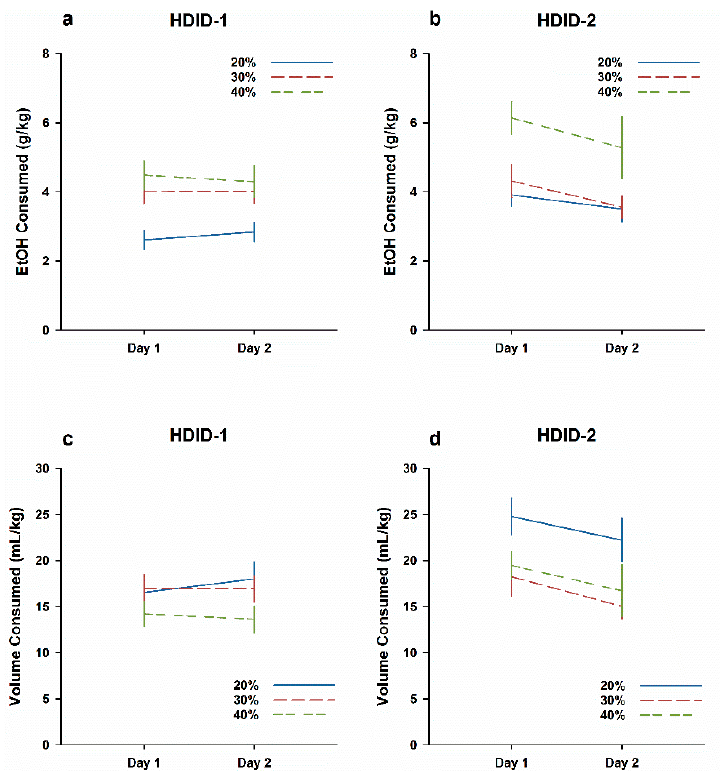
Figure 3. HDID-2 but not HDID-1 mice show a CTA after ingesting higher EtOH concentrations. Figure 3. HDID ‐ 2 but not HDID ‐ 1 mice show a CTA after ingesting higher EtOH concentrations. Mean ± SEM EtOH drinking during the initial 2 h each day is shown for groups of 23–24 mice per Mean ± SEM EtOH drinking during the initial 2 hr each day is shown for groups of 23–24 mice per genotype and concentration, collapsed on sex. ( a , b ) Dose EtOH ingested in g/kg. ( c , d ) Volume of 20% genotype and concentration, collapsed on sex. ( a, b ) Dose EtOH ingested in g/kg. ( c, d ) Volume of EtOH solution consumed in 20% EtOH solution consumed in mL/kg.